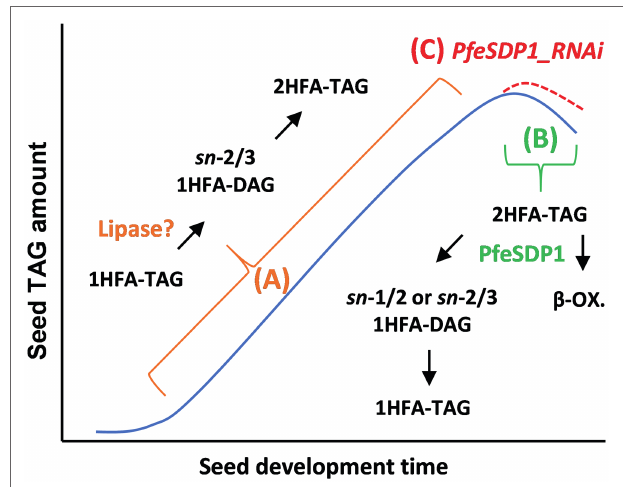
FIGURE 7 | Model of lipase action in P. fendleri oil accumulation. In many oilseeds TAG accumulates over seed development, then TAG levels drop ~10%–20% during seed maturation (blue line). (A) In P. fendleri recent results suggest an uncharacterized lipase is involved in remodeling 1HFA-TAG to 2HFA-TAG during TAG biosynthesis. (B) In wild-type P. fendleri PfeSDP1 action during late seed development and/or seed maturation leads to TAG turnover and the β -oxidation ( β -ox.) of fatty acids reducing total oil amount. Some of the products of 2HFA-TAG turnover are remodeled into 1HFA-TAG. (C) The PfeSDP1_RNAi lines reduce TAG turnover and remodeling of 2HFA- TAG to 1HFA-TAG, thus increasing total oil amount (red dashed line) and HFA amount. Because PfeSDP1_RNAi lines only decreased expression of PfeSDP1 up to 50%, this result suggests a knockout mutation of PfeSDP1 may further increase seed